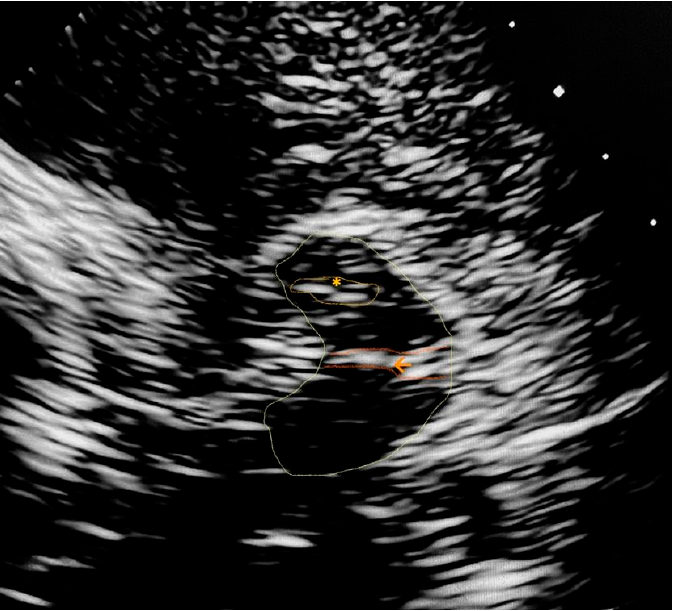
Figure A1. 7 MHz transducer. The silhouette of midbrain is marked with a colored line. Substantia nigra (*) and brainstem raphe (arrow) can be identified.